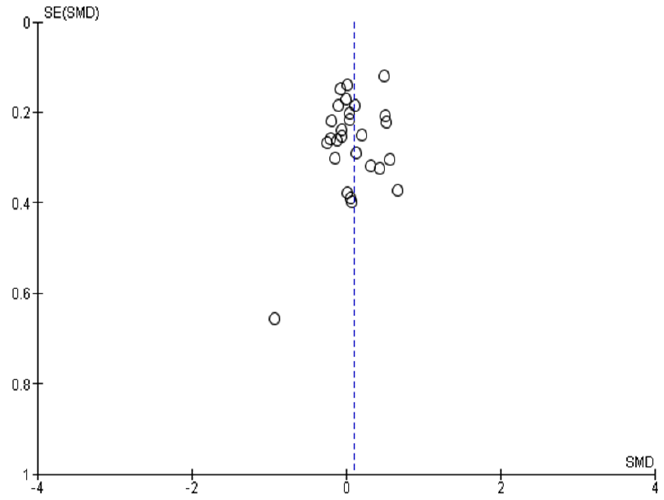
Figure 12. Funnel plot for publication bias.